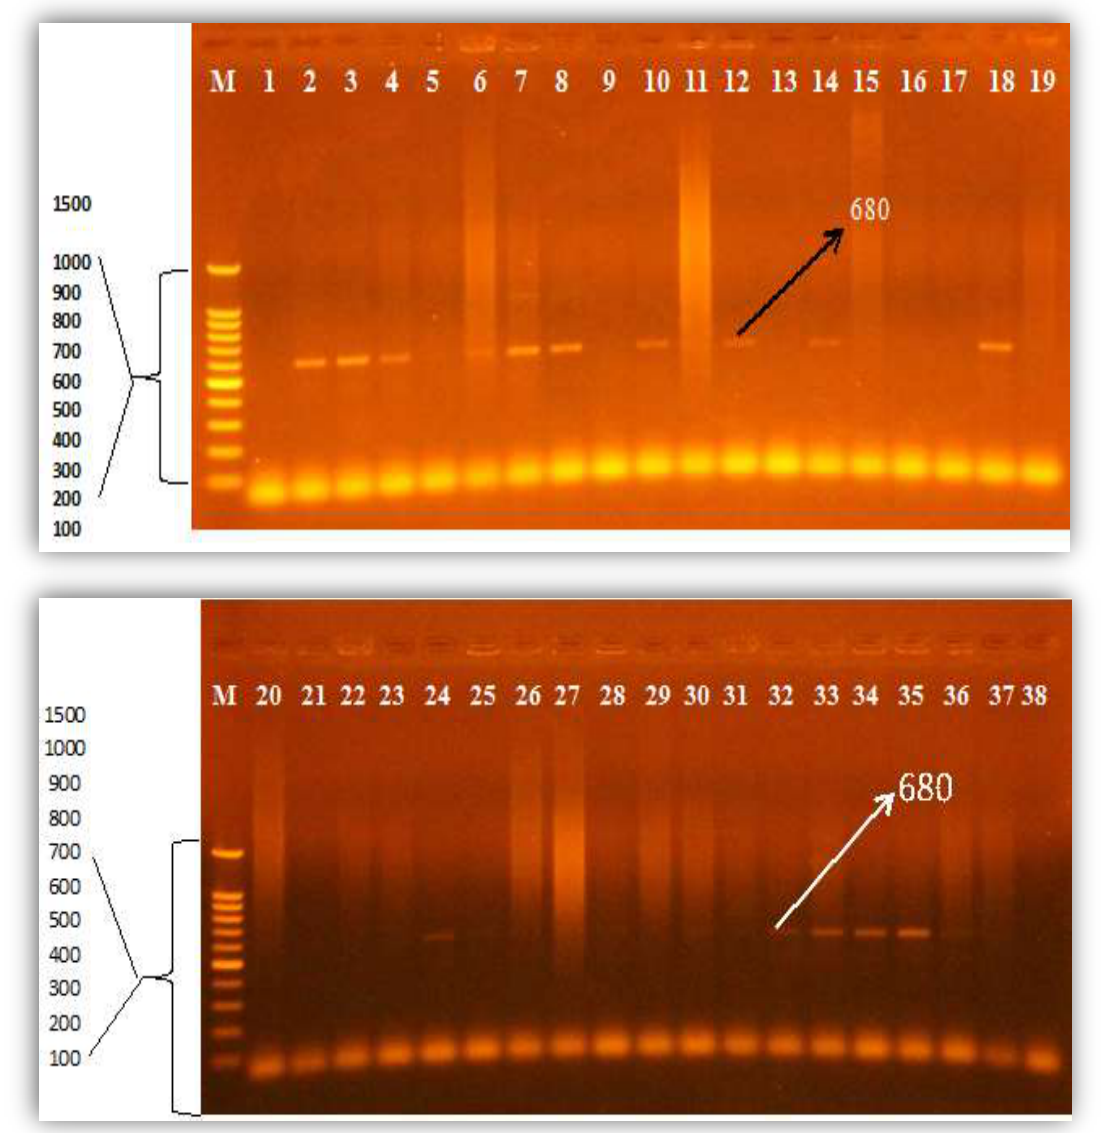
Figure 1: Electrophoresis of PCR product for detection cva C gene (680 bp) in A. baumanniii isolates on 2% agarose and 100 volts for 80 min. The M ladder (100-1500 bp); the 2, 3, 4, 6, 7, 8,10,12,14, 18, 24, 32, 33, 34, 35 and 36 were positive